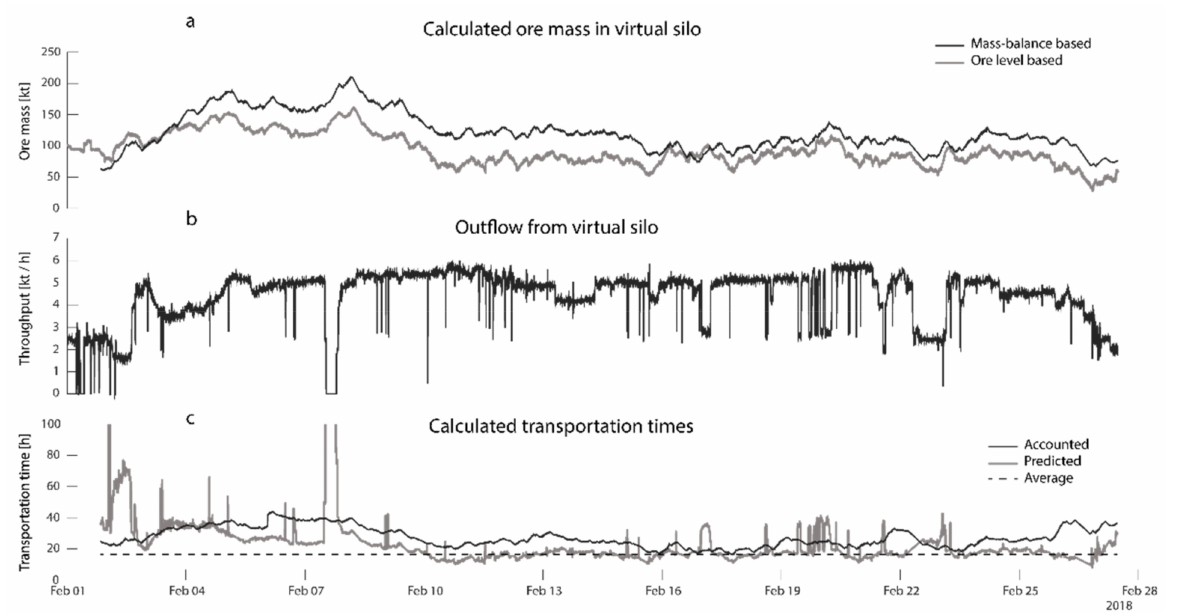
Figure 10. Subfigure ( a ) shows the calculated ore mass based on the mass-balance (black) and the ore levels (grey). Subfigure ( b ) shows the outflow. Subfigure ( c ) shows the average (dashed), the accounted (black) and the predicted (grey) transportation times in